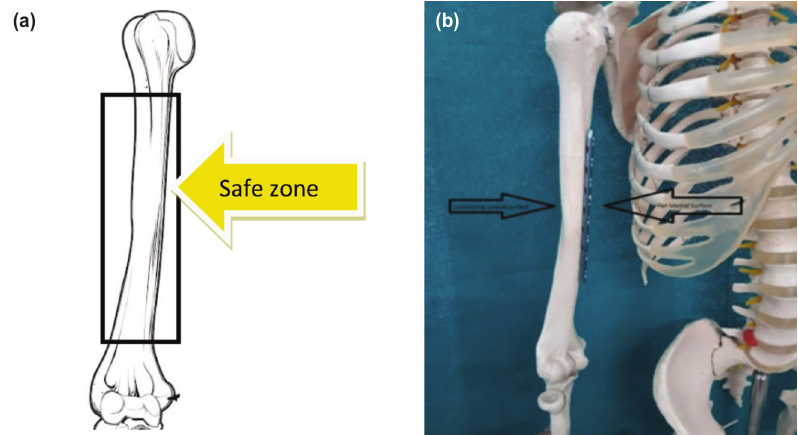
(a,b) Diagrammatic presentation of the safe zone of humerus, where plate can be apply medially through the anterolateral Fig. 4: approach. Lateral surface is undulation whereas Medial one is